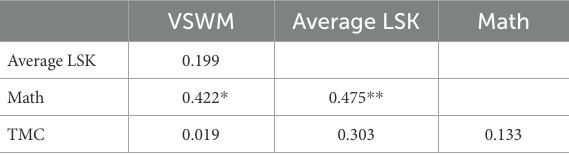
TABLE 6 Results from Spearman’s Rho bivariate correlation analysis for females ( n = 42). VSWM